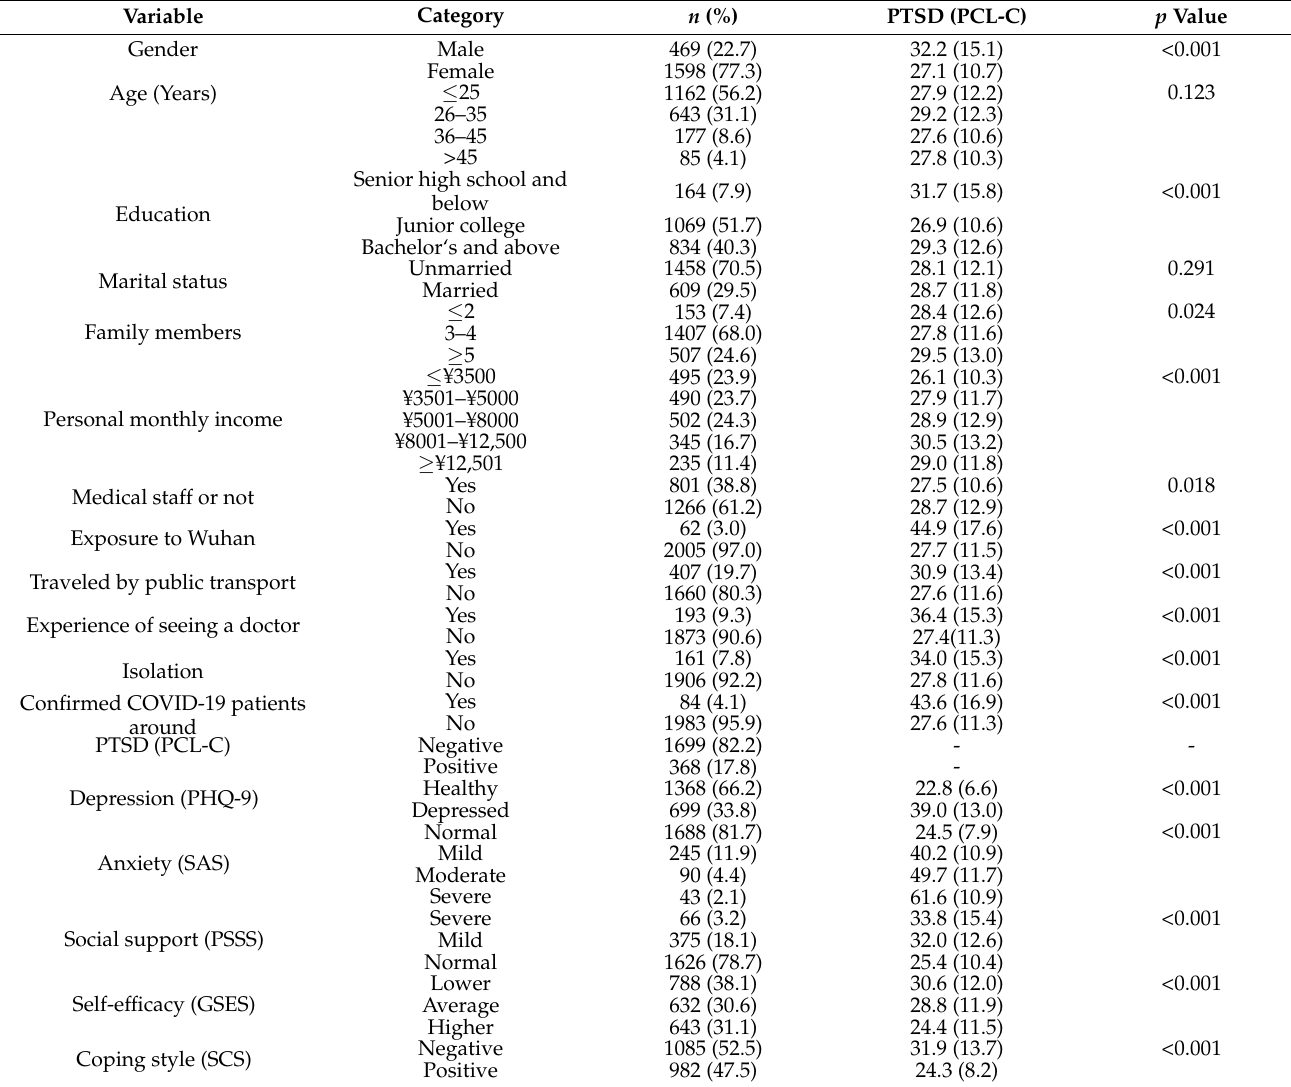
Table 2. Descriptions of all indexes ( n =